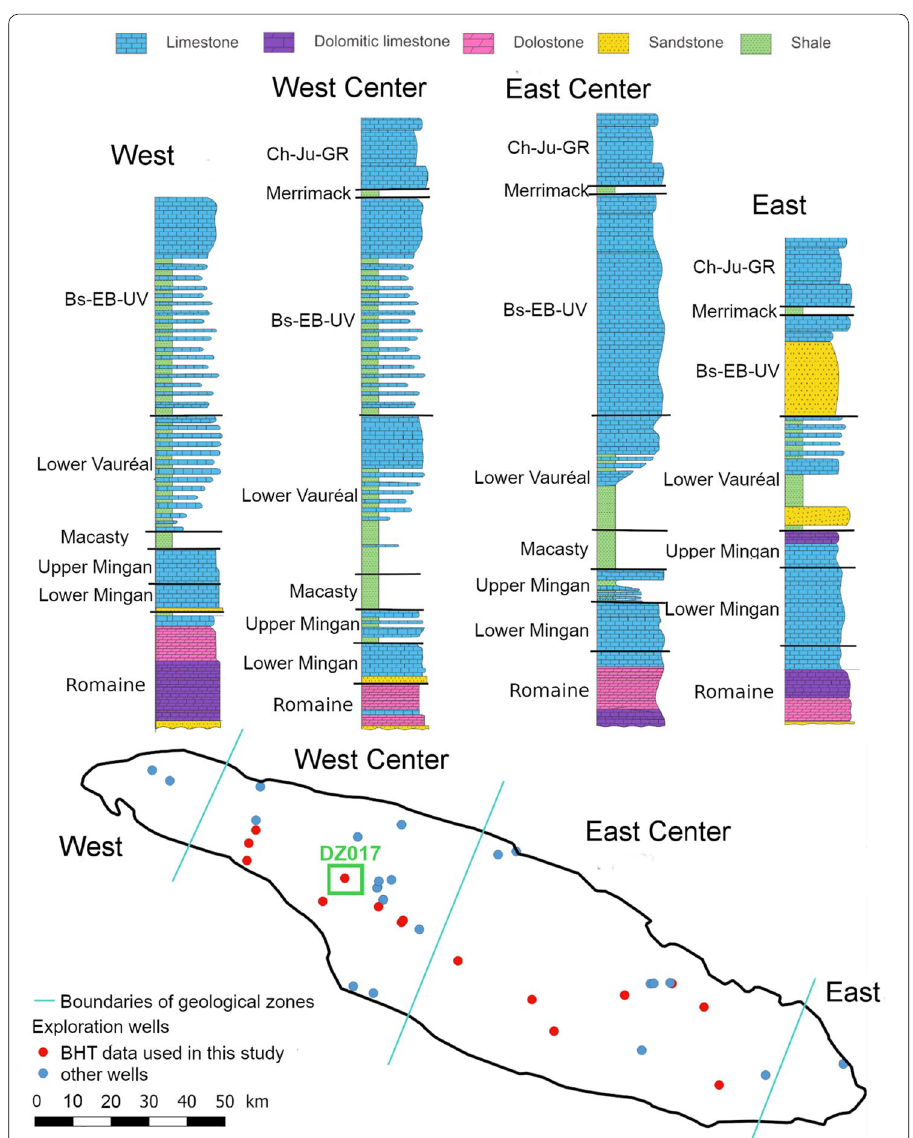
Fig. 4 Synthetic lithological logs and delimitation of lithological zones of the Anticosti Island. Ch–Ju–GR thermal unit grouping Chicotte, Jupiter and Gun River formations. Bs–EB–UV refers to the Becscie, Ellis Bay and Upper Vauréal formations